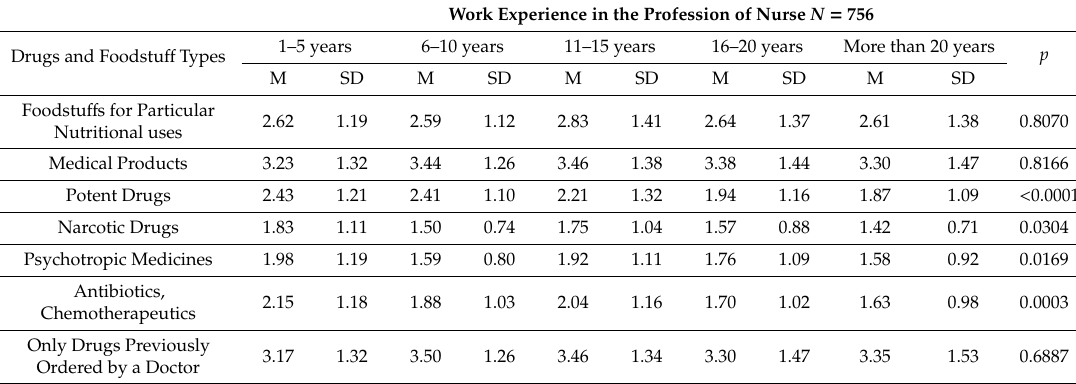
Table 4. Readiness to ordain medicines / agents vs. work experience in the profession of nurse.